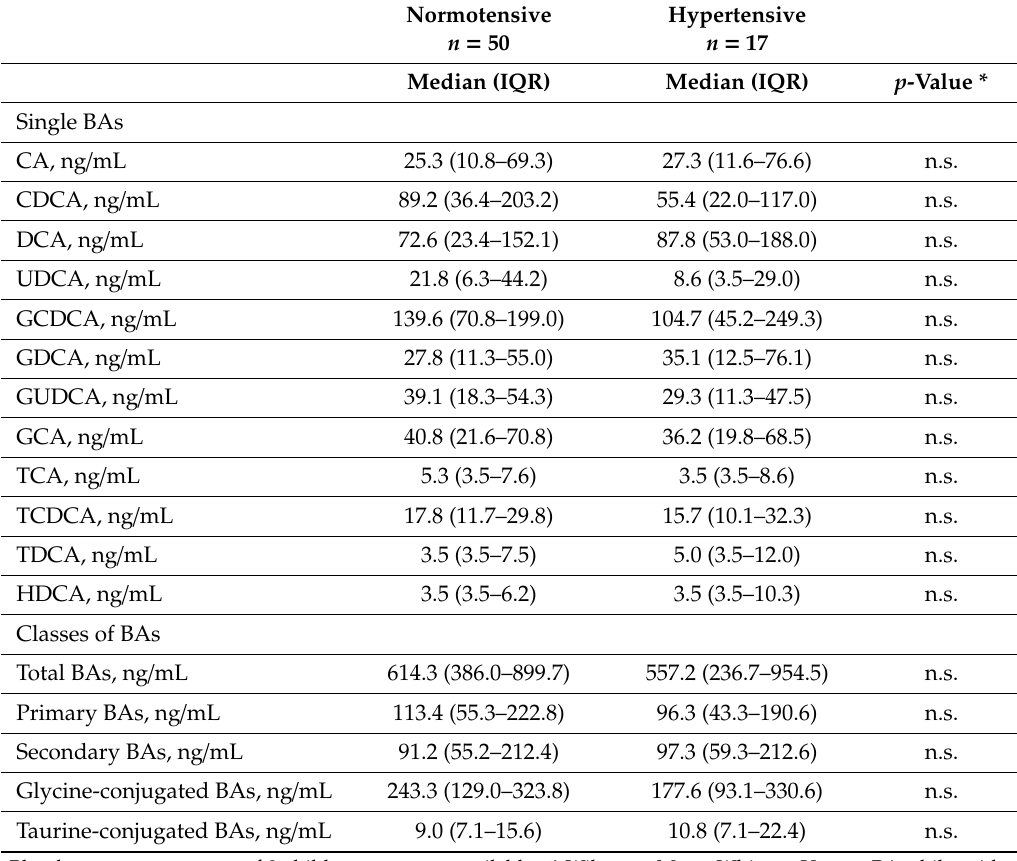
Table A2. Bile acids concentrations in normotensive and hypertensive obese children and